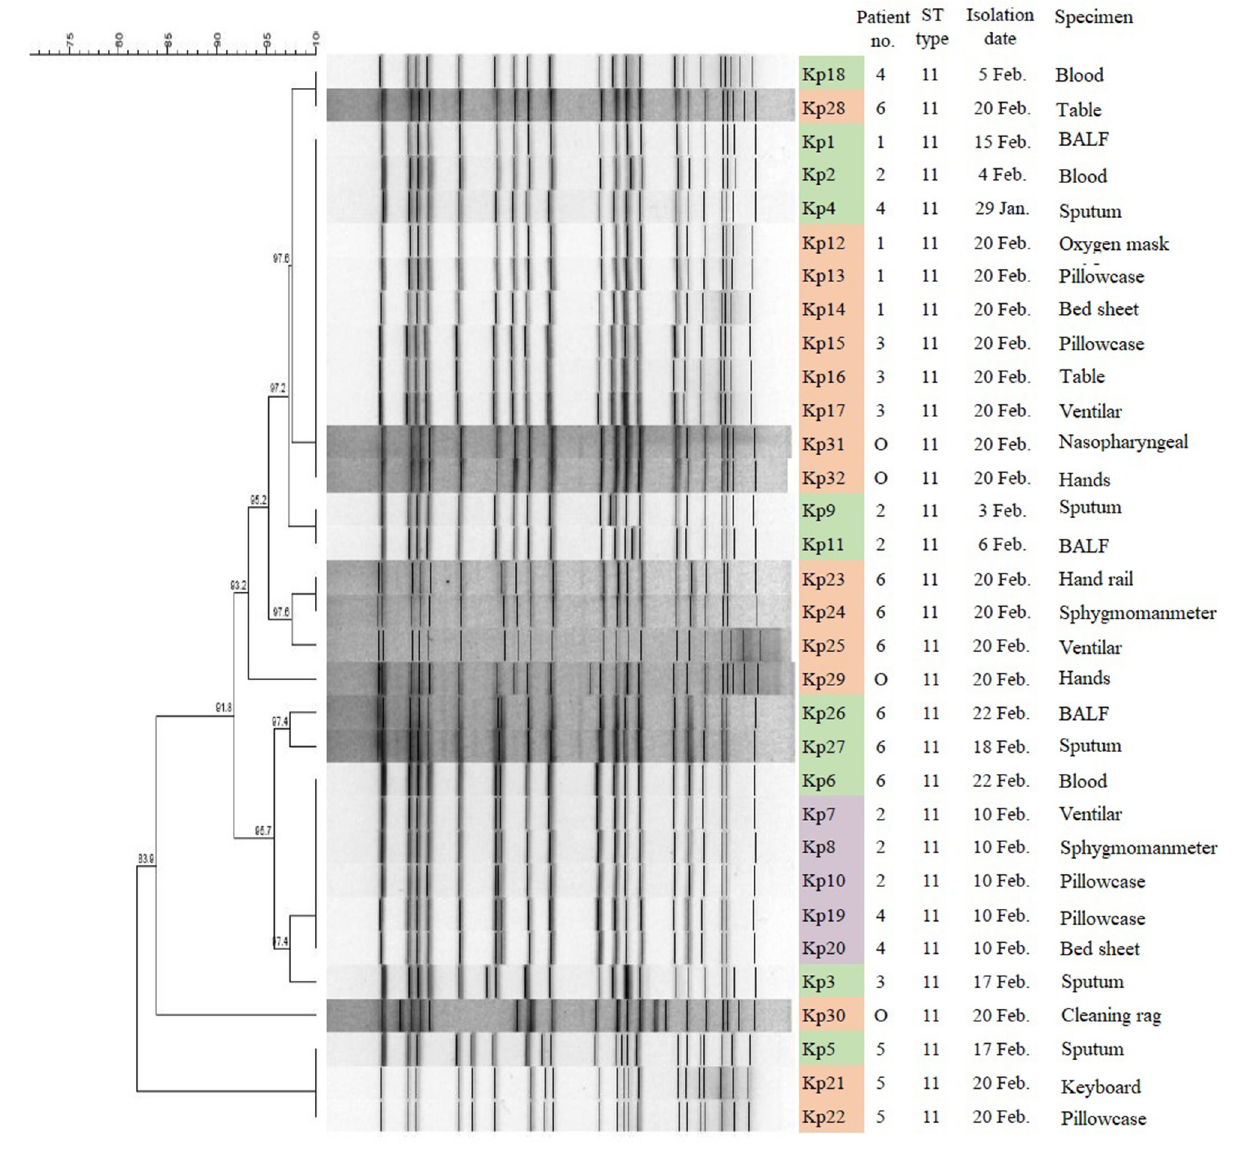
FIGURE 3 | PFGE results and MLST typing for 32 CR-hvKP isolates. Green represents strains isolated from clinical specimens of six patients; purple represents strains isolated in hospital environment on February 10, 2019; and orange represents strains isolated in hospital environment on February 20, 2019. “O” represents strains isolated from hands of cleaner in